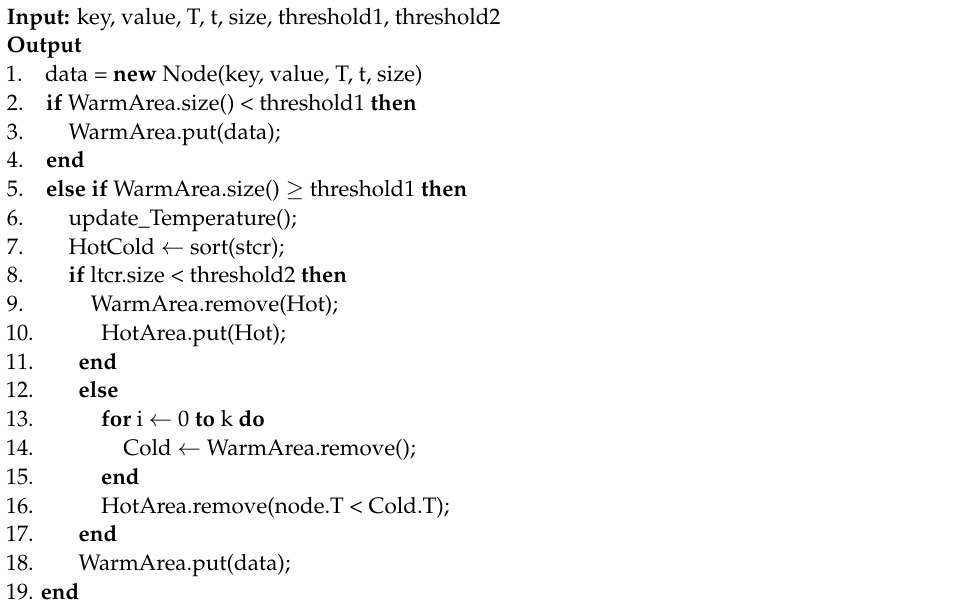
Algorithm 1. The process of algorithm SL-TCR